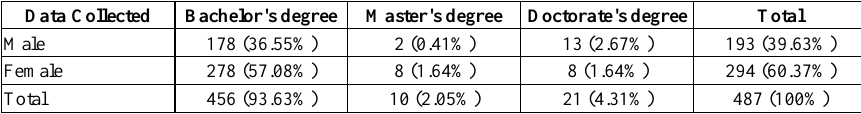
Table 2. Data collected classify by gender and education level.